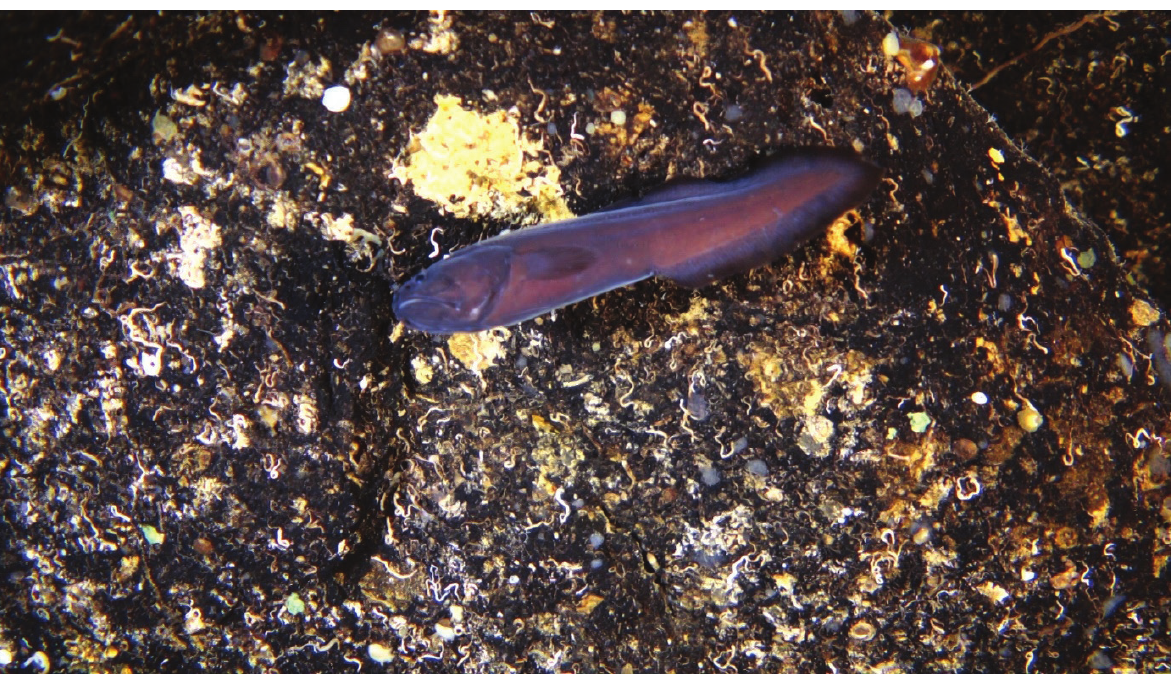
Figure 4. Image grab from ROV footage collected on 20 June 2016 at a depth of 10 m (36º01.106′N, 014º14.730′E) showing an individual of Grammonus ater . Image: Enrique Talledo/OCEANA © LIFE BaĦAR for